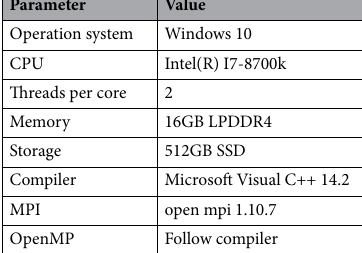
Table 1. Specifications of computer.